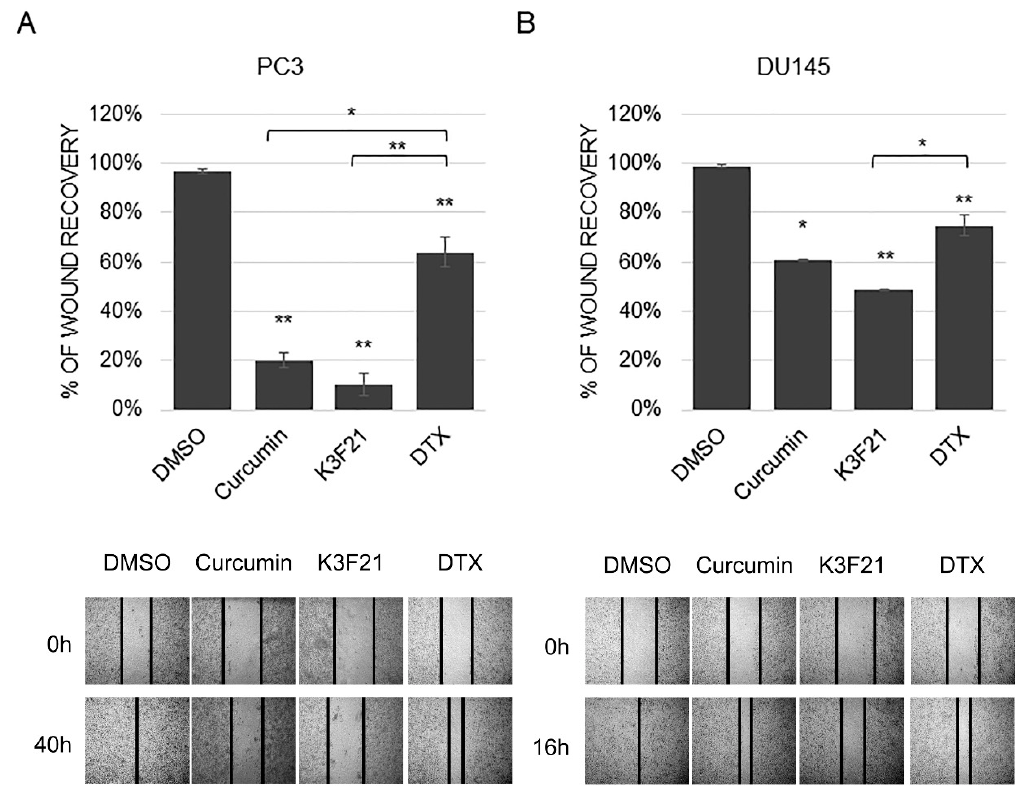
Figure 7. Inhibition of cell migration by curcumin, K3F21 and DTX. The percentage of wound recovery was assessed following DMSO, curcumin, K3F21 and DTX administration at GI50 doses in PC3 ( A ) and DU145 ( B ) after 40 and 16 h, respectively. Representative images are shown in lower panels. p values * < 0.05, ** < 0.01, *** < 0.001, **** < 0.0001.